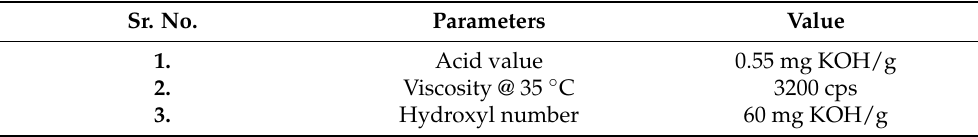
Table 4. Physical properties of the polyester polyols. Sr. No.